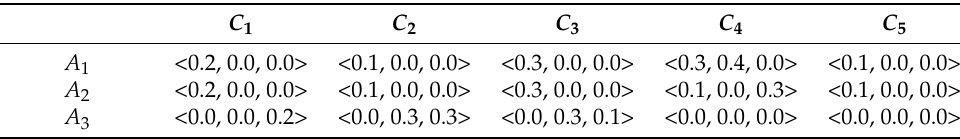
Table 9. The SVNPDA.